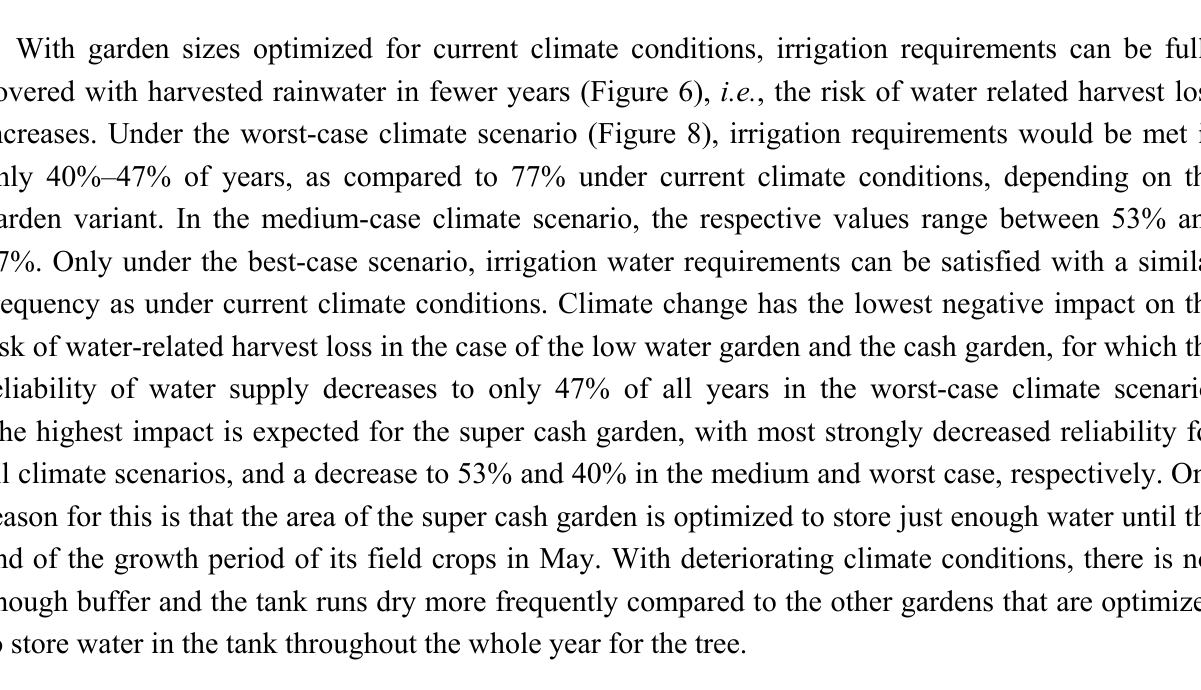
Figure 7. Irrigation requirement for present climate and projected for 2050 (mm/m 2 ) (data base: